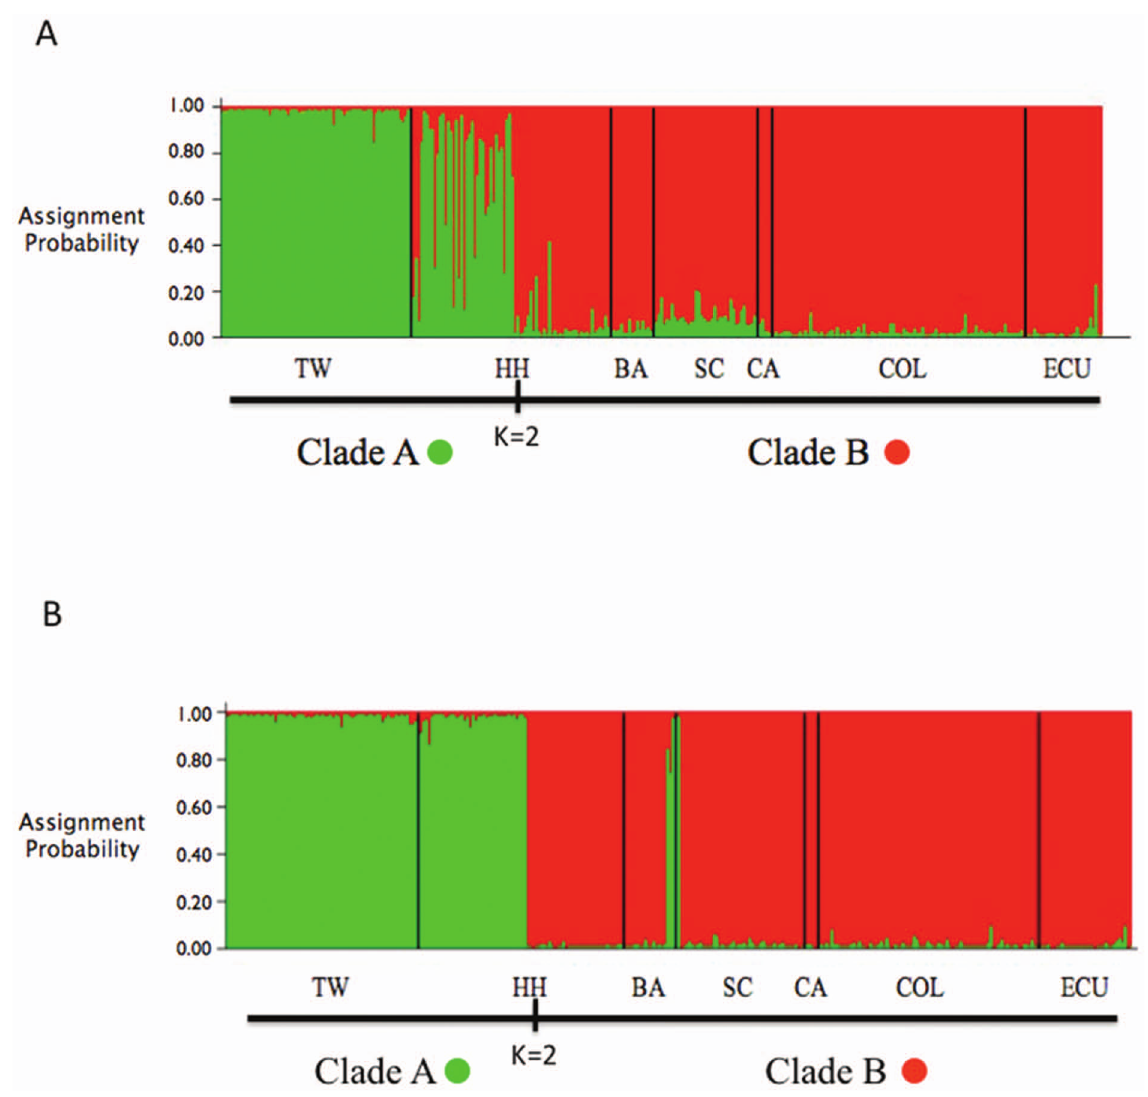
Figure 4. Structure bar plot showing the assignment probabilities (K=2) of each genotyped individual of A.pelagicus from the different sampling locations in the Pacific Ocean. A) sampling region used as location prior. B) COI haplotype clade (A or B) used as the location prior.